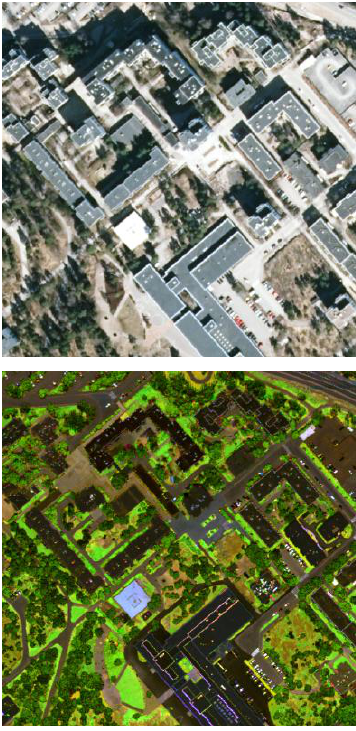
Figure 2. Comparison of an aerial ortho image and Titan intensity image in a 300 m × 300 m subarea. Ortho image © National Land Survey of Finland,